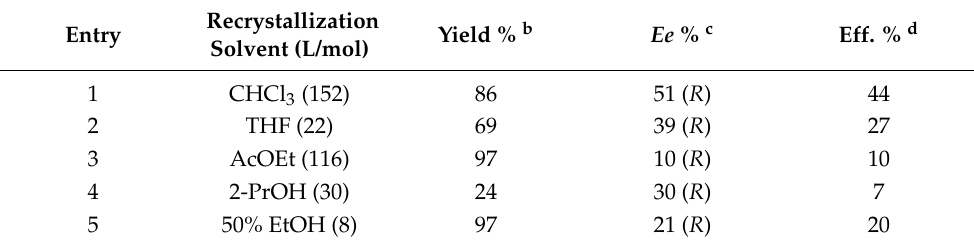
Table 1. Optical resolution of racemic 3-hydroxy-4-phenylbutanoic acid ( rac - 1 ) with ( − )-ADPE a .